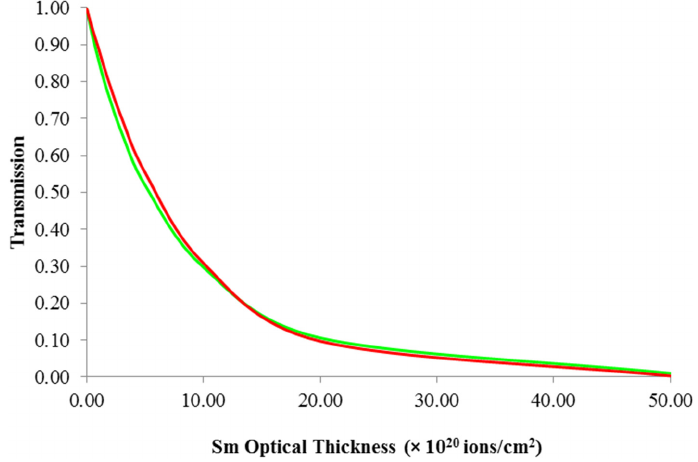
Figure 41. Transmission of Nd:YAG 1064.2 fluorescence through a Sm:YAG layer, as a function of optical thickness (Sm doping density—Sm:YAG thickness product), for a Nd:YAG FWHM gain bandwidth of 1.1 nm, and assuming a Gaussian (red) or Lorentzian (green) gain spectral profile.